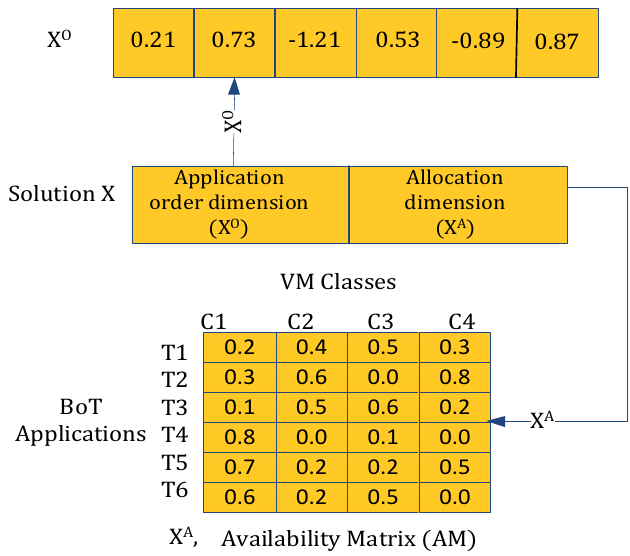
Figure 3. Encoding of the initial solution.